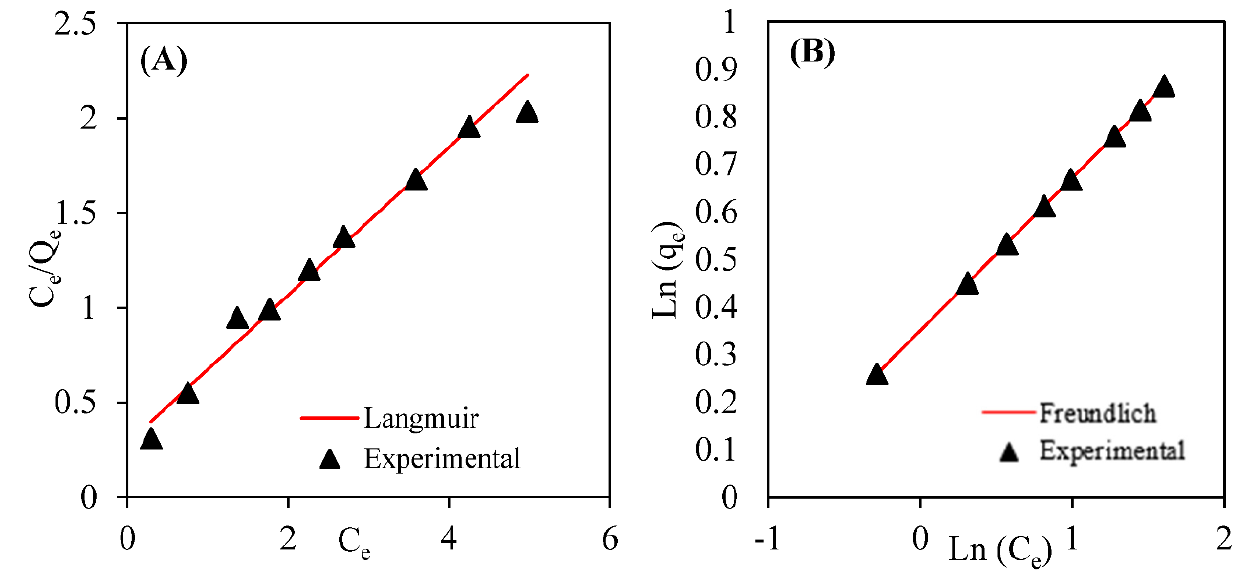
Figure 6. Linear plots of ( A ) Langmuir and ( B ) Freundlich isotherm models for the CPX biosorption